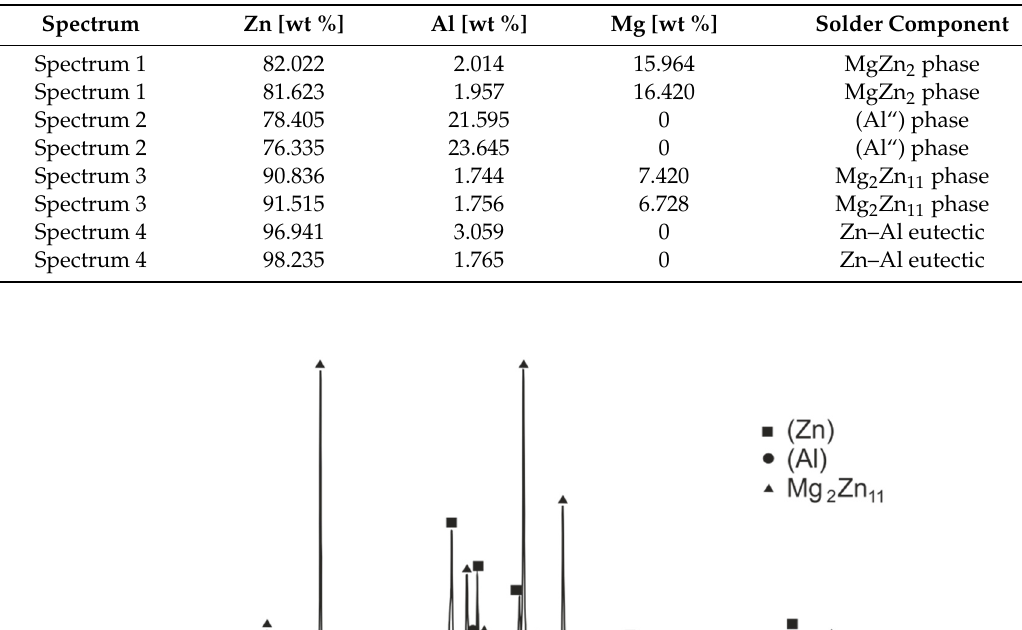
Figure 10. The energy-dispersive X-ray spectroscopy (EDX) analysis of Zn5Al3Mg soldering alloy. Table 4. The phase composition results of Zn5Al3Mg solder alloy.